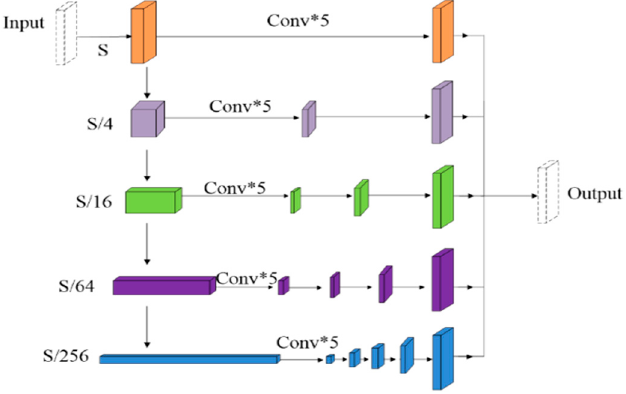
Figure 14. Multi-resolution pyramid networks for moiré pattern removal [29].